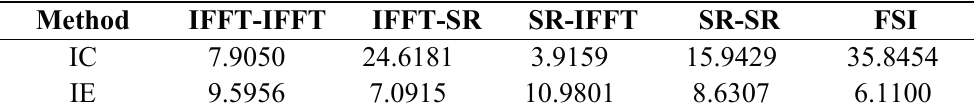
Table 1. ISAR image